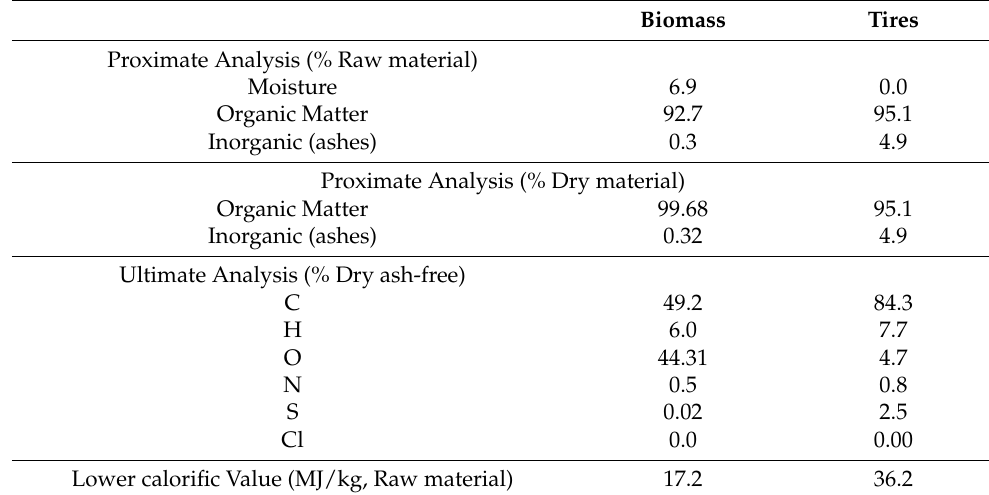
Table 4. Proximate and ultimate analyses of waste considered in the present model